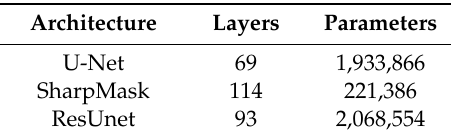
Table 2. Total number of layers and parameters in each deep learning (DL) architecture used in this study.